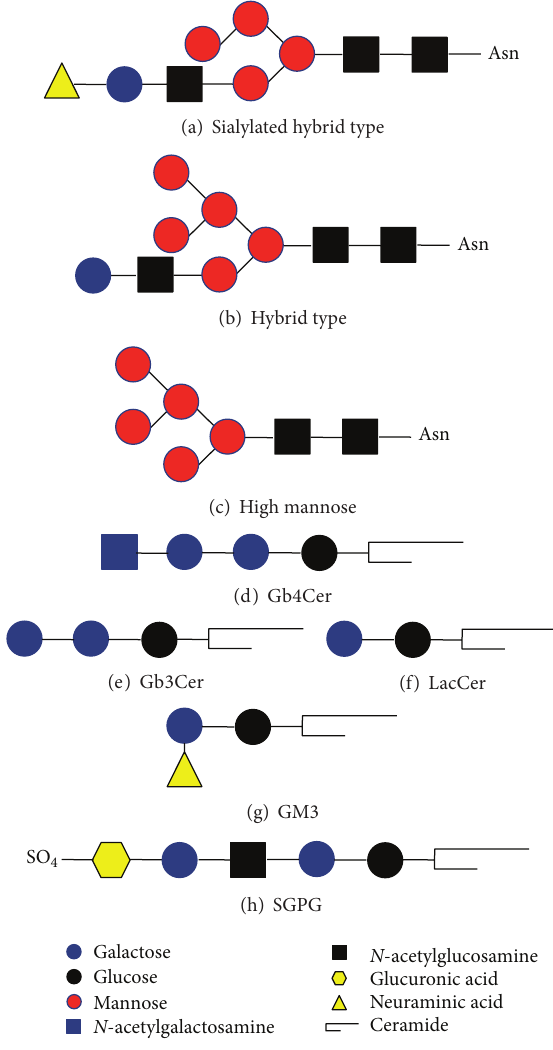
Figure 1: Structures of glycoconjugates. (a) One of the sialylated hybrid-type glycans described in reference [4] is shown. (b) and (c) N -glycans described in reference [5] are shown. (d)–(h) GSLs described in each reference are